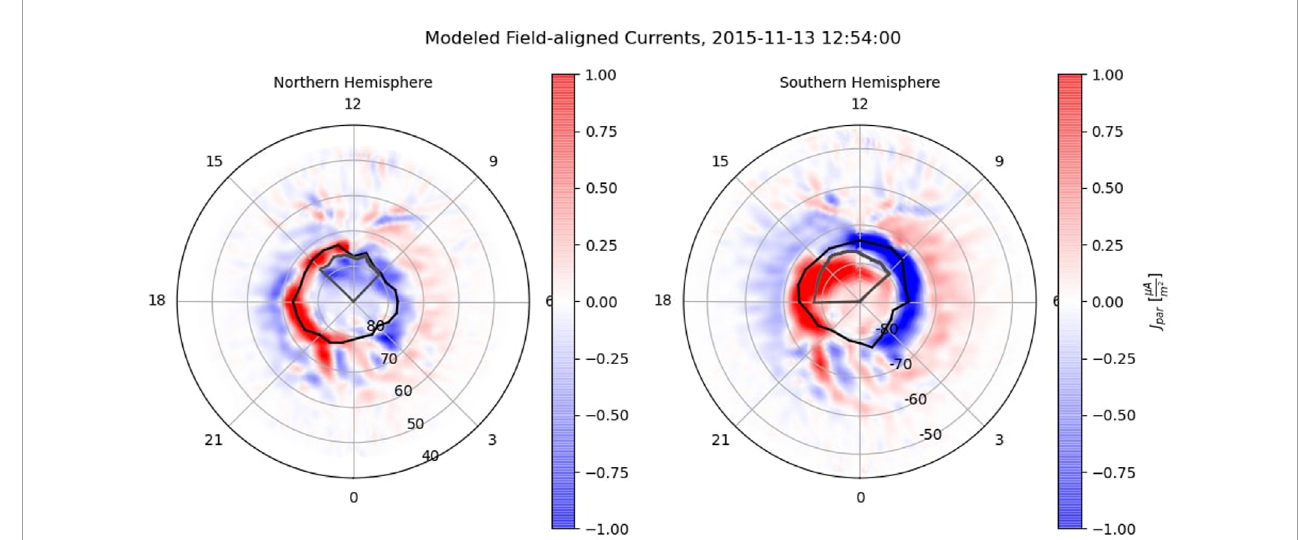
FIGURE 8 MIX currents for the time of the MMS crossing. Red current is flowing out of the ionosphere and blue is flowing in. The southern hemisphere is once again in a “glass-Earth” projection. The black tracings indicate the polar cap boundary and the regions circled in grey contain the currents possibly closing the bow shock. The model broadly reproduces the AMPERE-derived